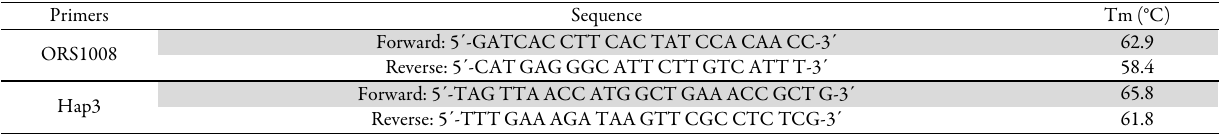
Table 3. The primer sequences of ORS1008 and Hap3 primer pairs used in the study